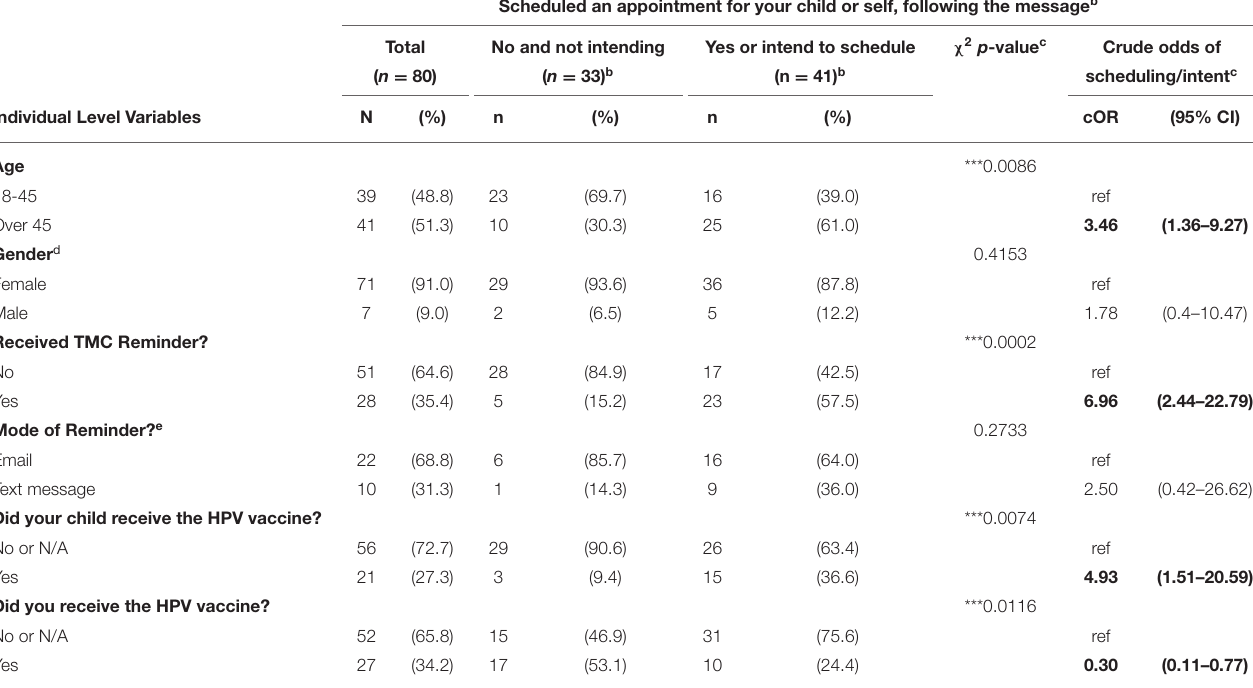
TABLE 2 | Human papillomavirus (HPV) vaccination survey following reminder intervention, Telluride Medical Center (TMC) 2020 a